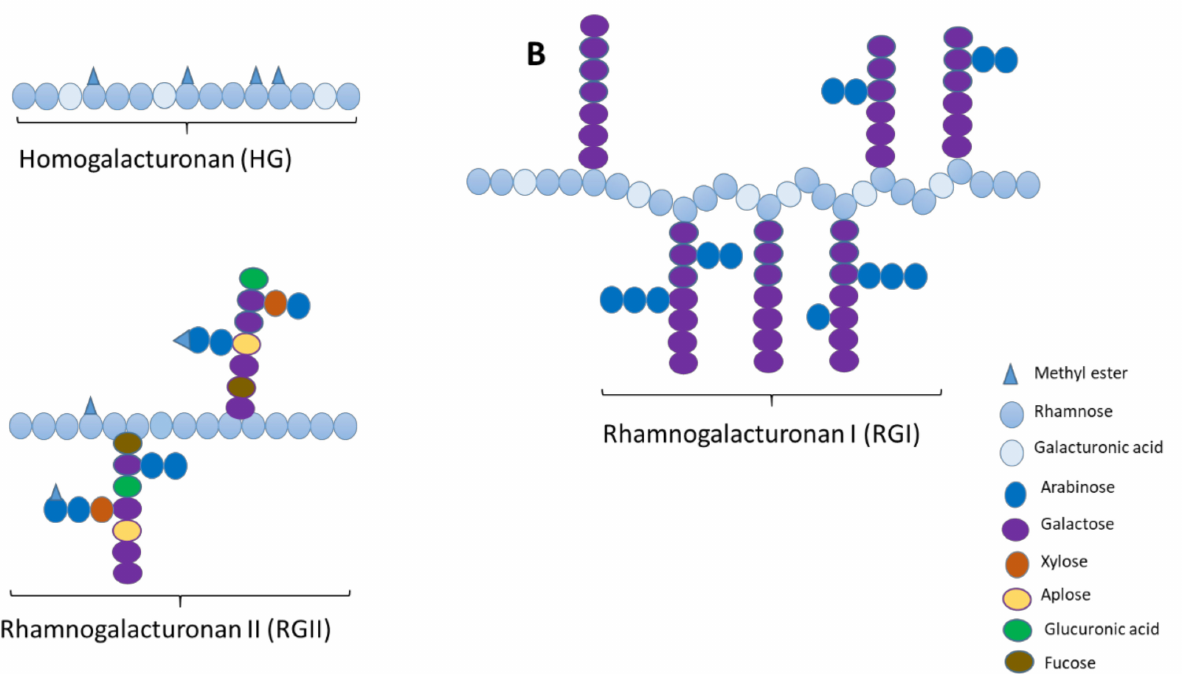
Figure 1. Simplified structures of modified pectin. ( A ) The Homogalacturonan (HG) “smooth region” is responsible for gelling ( B ) The Rhamnogalacturonan 1 (RGI) “hairy region” is responsible for non-gelling ( C ) Rhamnogalacturonan II (RGII) region